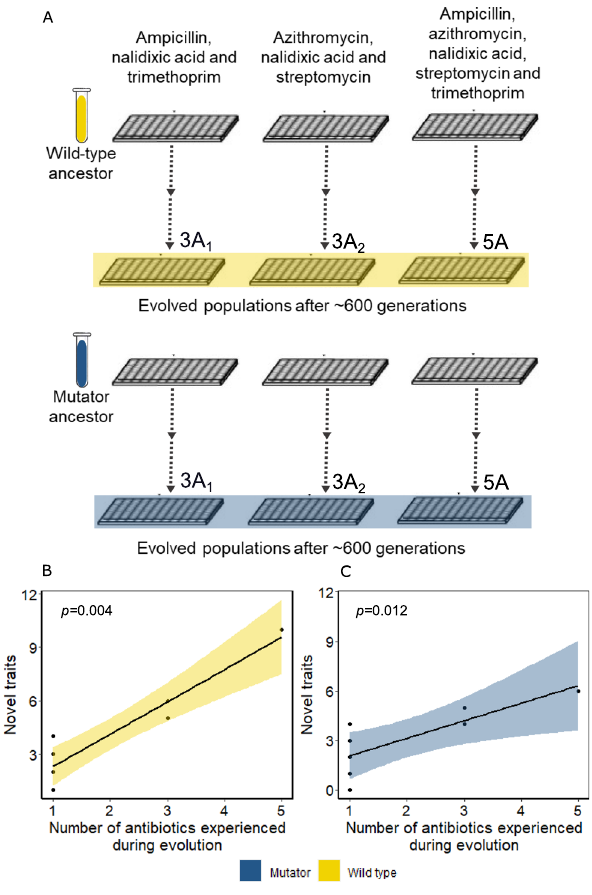
Fig. 2 | Evolution of novel traits without immediate bene fi t in complex anti- biotic environments A. Experimental evolution design in the three different complex environments 3A 1 , 3A 2 and 5A. We evolved eightpopulations ofwild-type and mutator strains (forty-eight populations in total, Methods) in increasing con- centrations of the indicated antibiotics for ~600 generations. At the end of the evolution experiment all populations could grow in the environment that con- tainedallthree(3A 1 and3A 2 )or fi ve(5A)antibioticsattheirrespectiveIC 90 . B , C The number of novel traits is signi fi cantly and positively correlated with the number of antibiotics experienced during evolution ( x -axis) for both the wild-type ( B , Spearman ’ s correlation, n =8, R =0.87, p =0.004) and the mutator strain ( C ,Spearman ’ scorrelation, n =8, R =0.82, p =0.012).Theshadedregionrepresents the 95% con fi dence intervals. Source data are provided as a Source Data fi